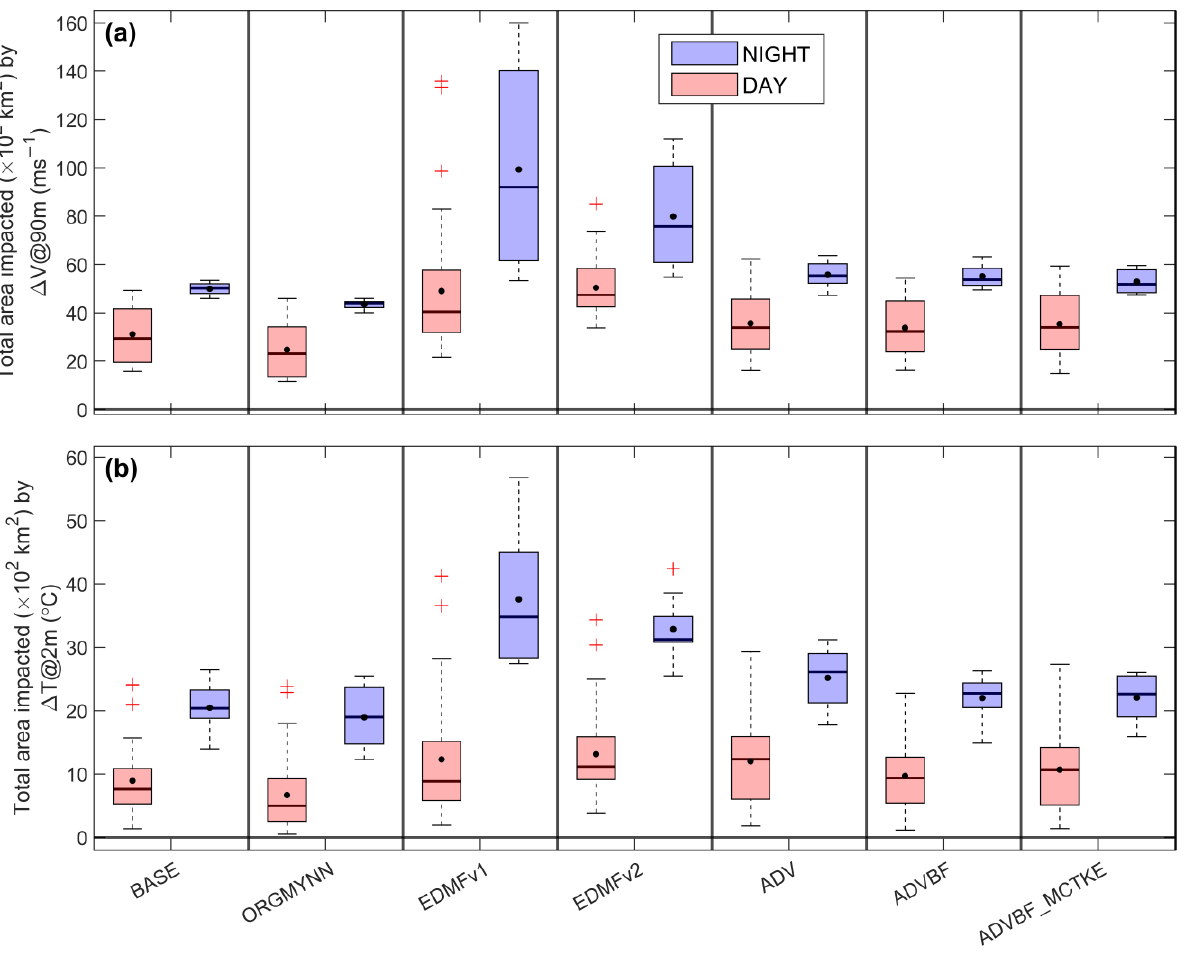
Figure 5. The daytime and nighttime impact area ( × 10 2 km 2 ) of ( a ) hub-height wind speed and ( b ) near-surface temperature differences under wind farm wake by considering the lower impact limits of |0.1| ms − 1 and |0.05| ◦ C. Box plots include the entire time period of the study. The larger values of TKE enhancements (positive TKE difference) are generally seen TKE difference) occurs here (Figure 6). The maximum increase in TKE at hub height (90 m) is 3.24 m 2 s − 2 for the BASE simulation. However, it is observed that the high positive hub-height TKE difference observed in the wind farm rapidly decreases downstream. In downstream regions, both negative and positive TKE differences are seen due to the change in the wind shear causing a change in shear production, which is one of the largest sources of TKE outside the rotor area as mentioned in Fitch et al. [12]. Therefore, too high of TKE levels are predicted at wind farm cells (Figure 6a – d) due to disabled TKE advec- tion, causing the accumulation of added TKE from wind farms over time. The modified MYNN scheme creates changes in simulated wind farm wake impacts. Using the original MYNN scheme [40] in ORGMYNN causes larger positive TKE differences within the wind farm but weakens positive TKE differences and exhibits larger negative TKE differences outside the wind farm (Figure 6b). EDMFv1 causes slight changes in the impact area and